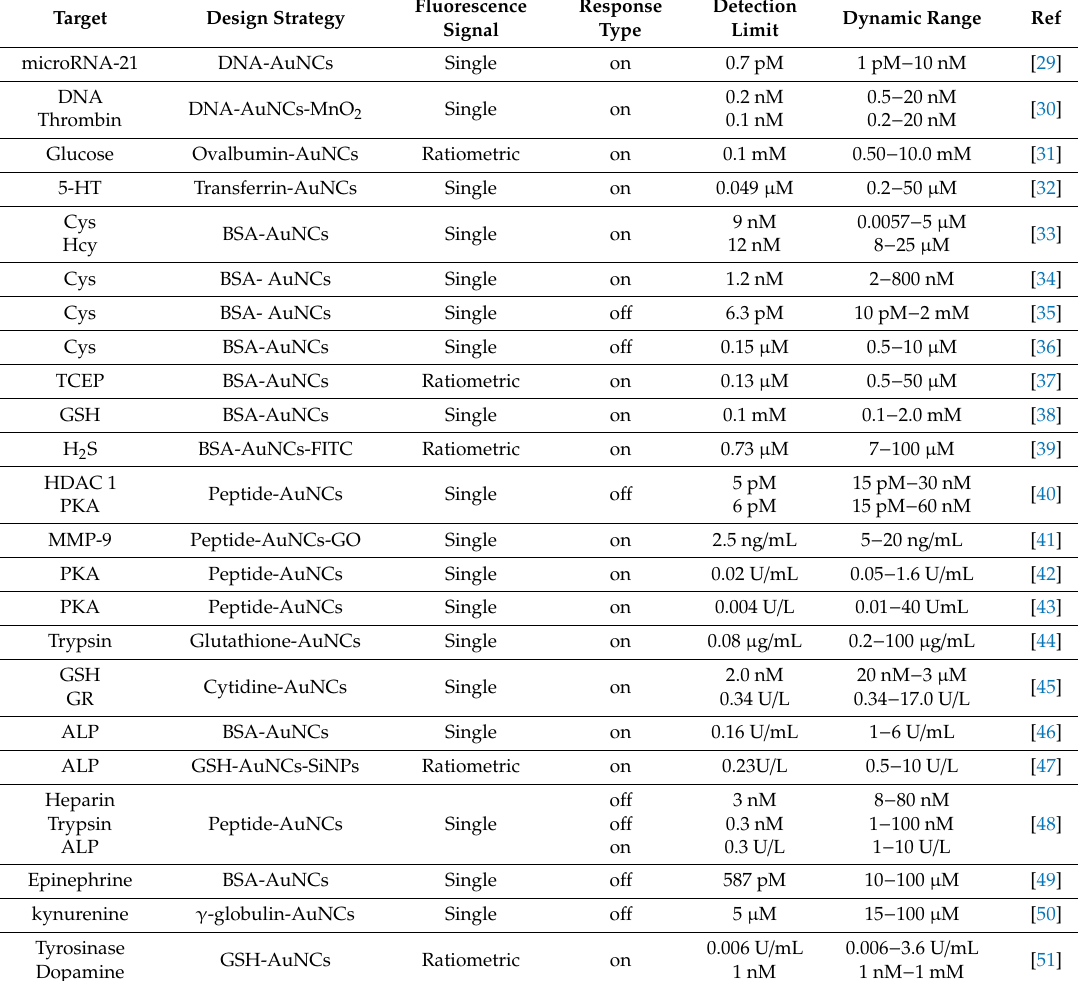
Table 1. AuNCs-based fluorescence biosensors for detection of diverse